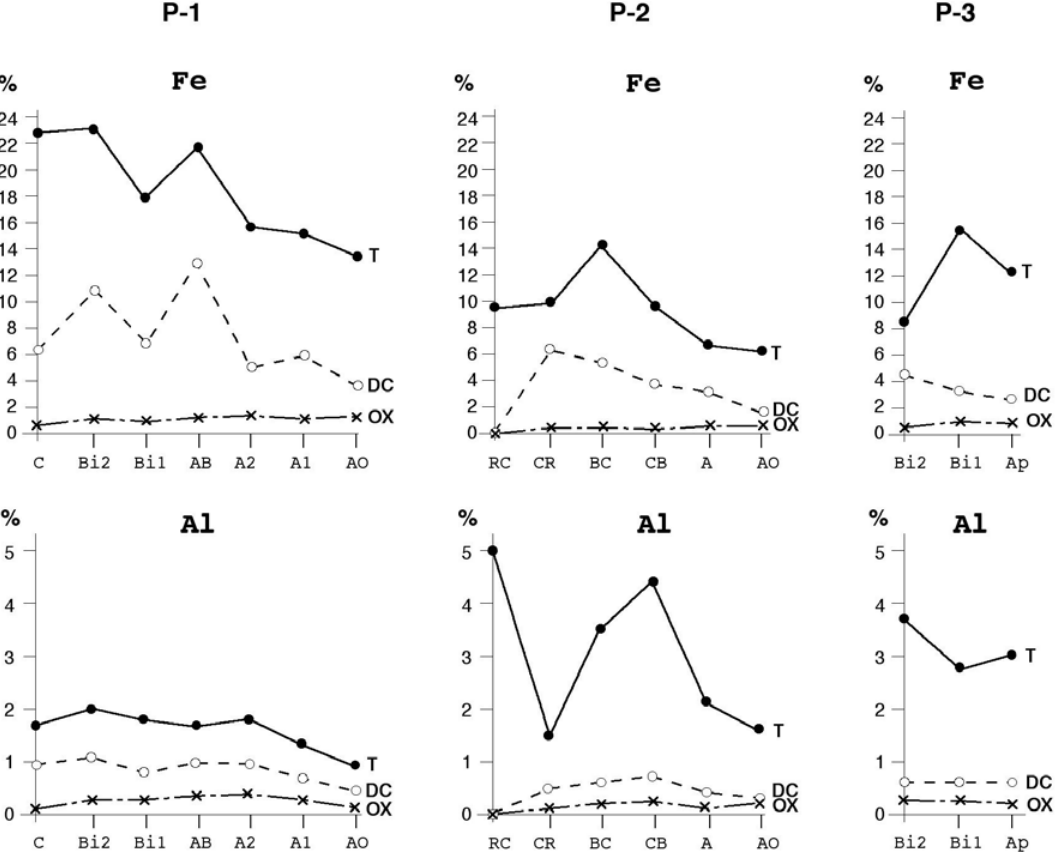
Figura 6. Análise total e extrações seletivas de Fe e Al. DC: ditionito-citrato (Buurman et al., 1996); OX: oxalato ácido de amônio (Blackmore et al.,